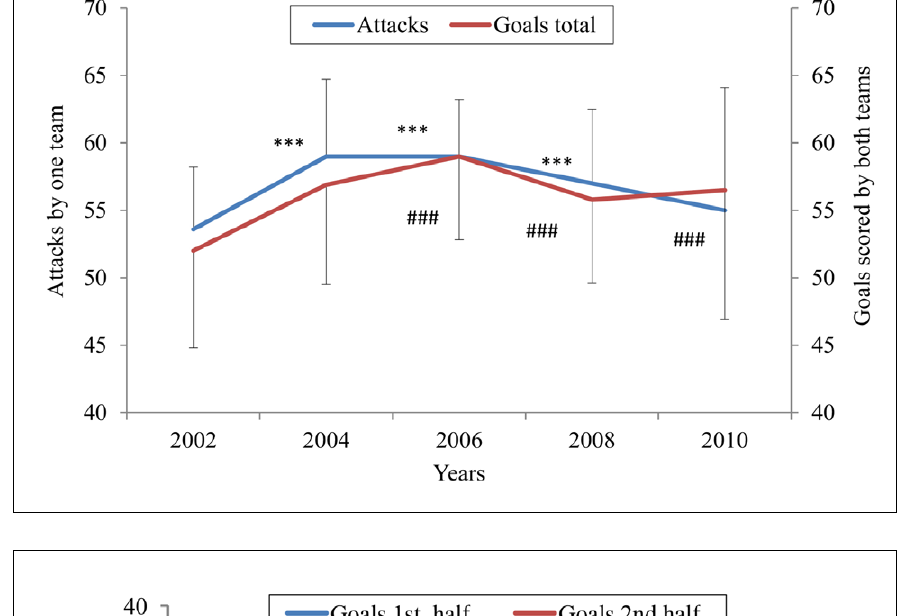
Figure 1. Attacks, goals scored in the years 2002–2010 of